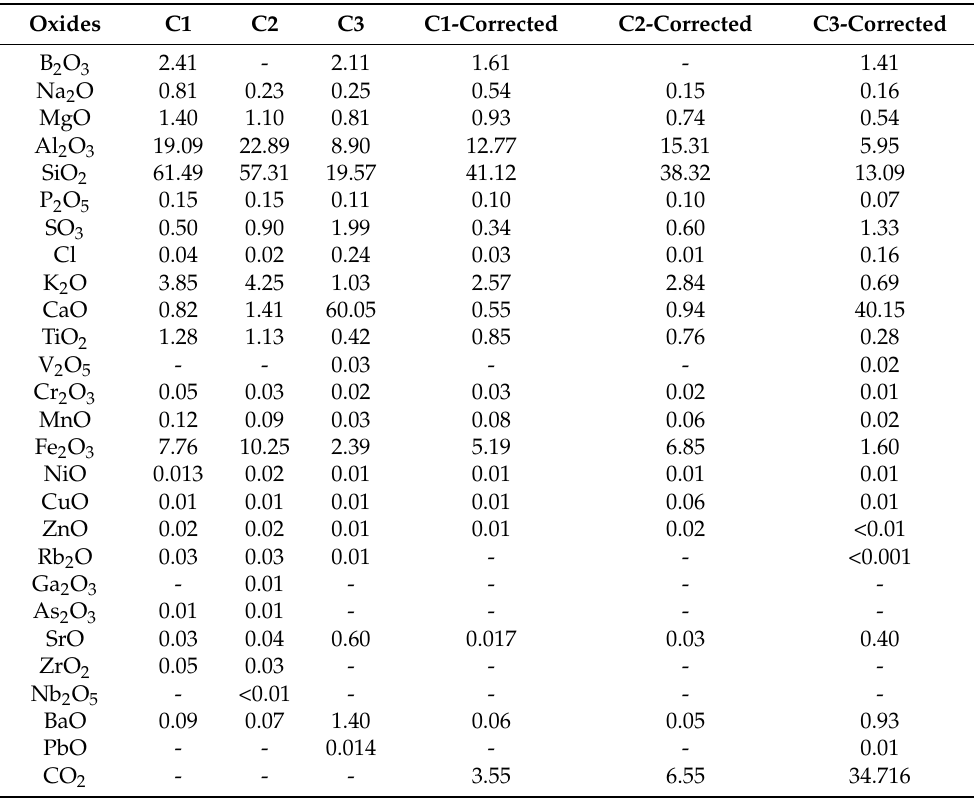
Table 2. XRF analysis (oxides weight %) of C1, C2 and C3 rock samples.